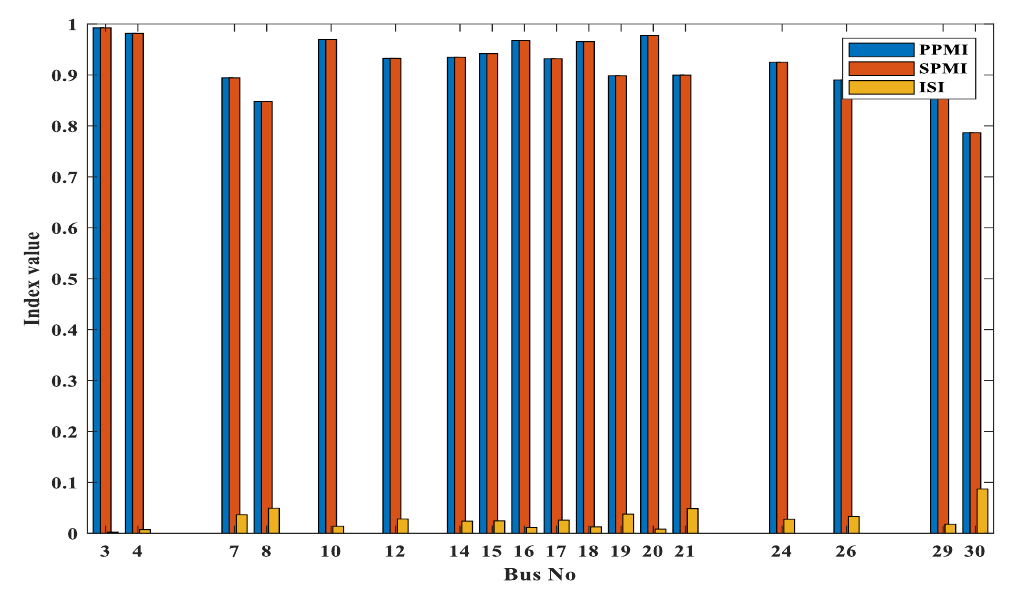
Figure 5. Stability indices for IEEE 30 bus test system